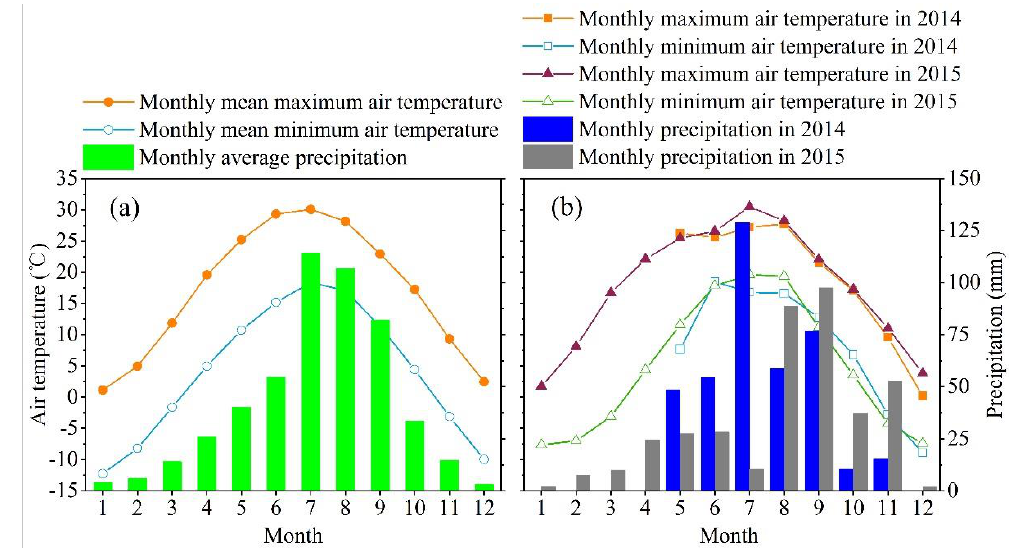
Figure 2. Climate background ( a ) and monthly precipitation and air temperature in 2014 and 2015 ( b ) in the study area. The monthly mean air temperature and precipitation data in the study area were obtained from the statistical data released by National Meteorological Center of CMA (http://www.nmc.cn/publish/forecast/ASN/qingjian.html). Since the AR-5 automatic weather station for monitoring meteorological factors in the study area was installed in late April 2014, the meteorological data was calculated from May 2014.